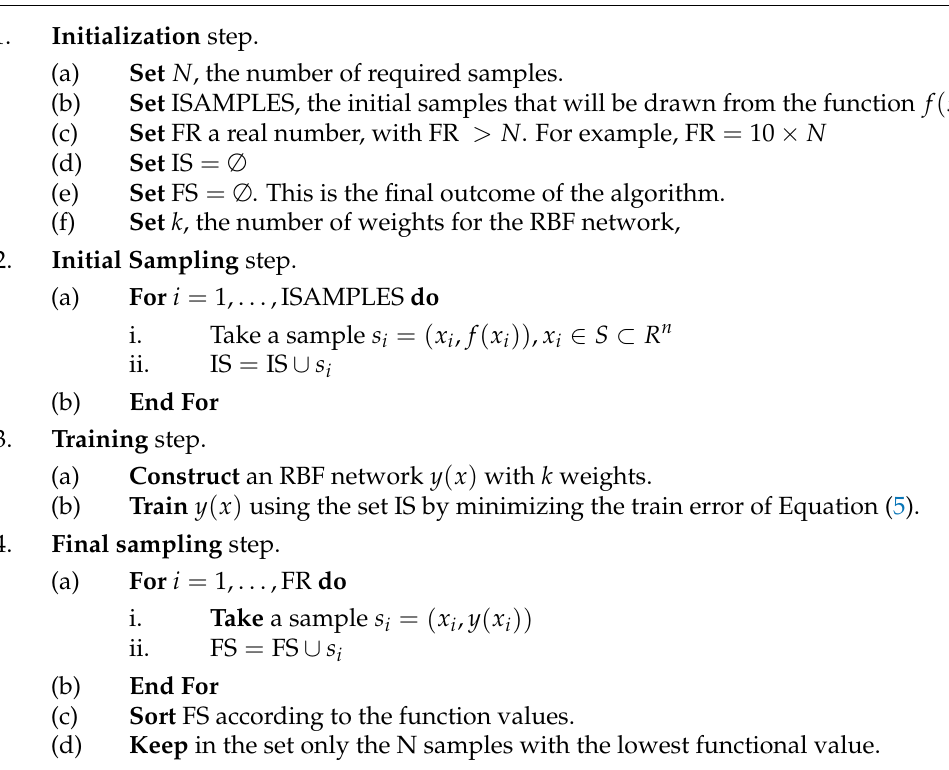
Figure 4. An example of an RBF network. Algorithm 2 The proposed sampling